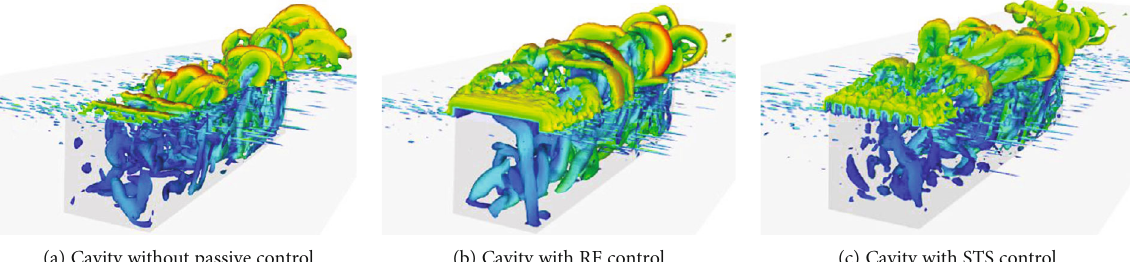
Figure 15: Isosurface of Q near the cavity ( Q = 7 × 10 6